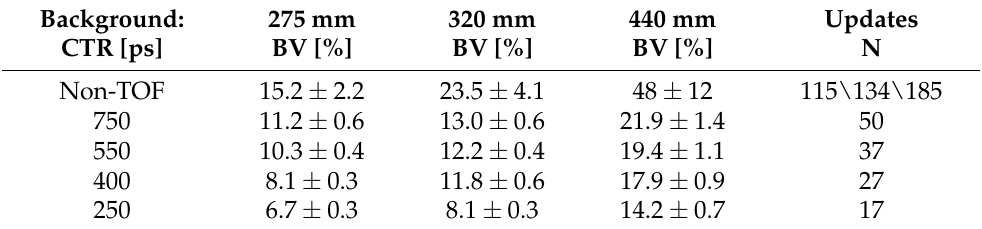
Table 4. Background variability (2 mm) with the proposed contrast recovery matching rule, matching to 50 updates at 750 ps CTR, as a function of CTR and background diameter. Values reported as mean ± one standard